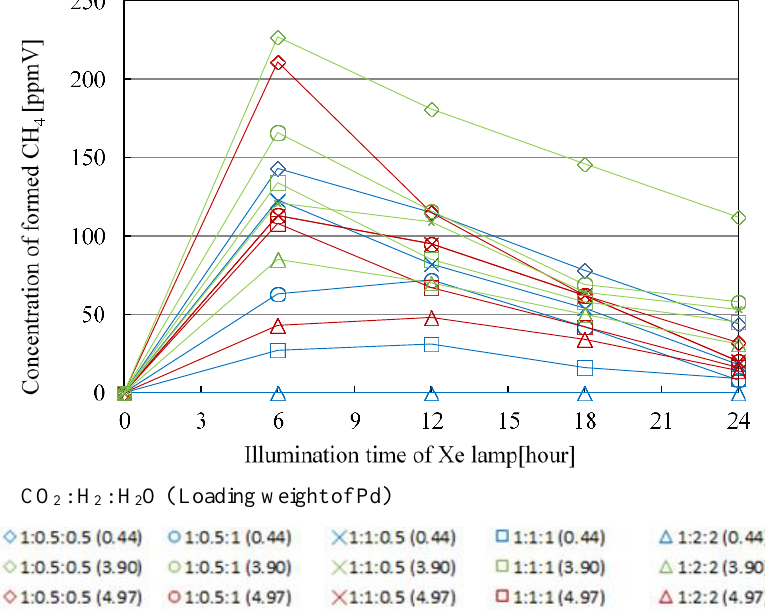
Figure 8. Change in concentration of formed CH 4 with the illumination time among different molar ratios of CO 2 /H 2 /H 2 O and Pd loading weight with UV light illumination.